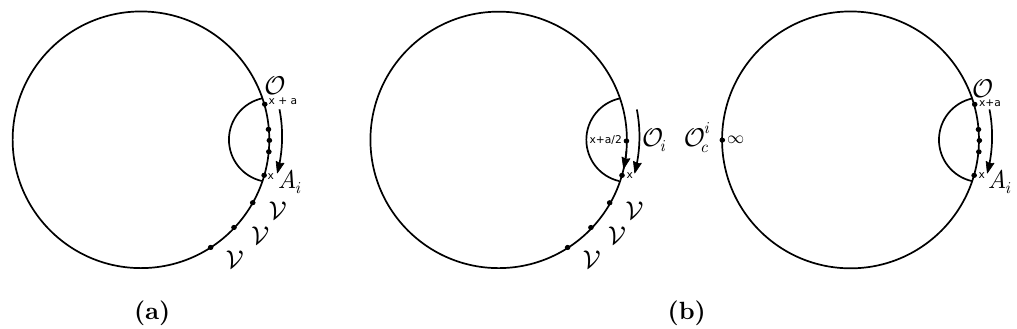
Figure 2. (a) We split the disc into two along a semicircle of diameter slightly larger than a . (b) The same con(cid:12)guration represented by two disjoint discs with insertion of a complete set of operators. When a ! 0, the left disc represents an operator O i at x i in the shifted background, with coe(cid:14)cients computed as an expectation value on the right disc. The arrows represent the limit a !